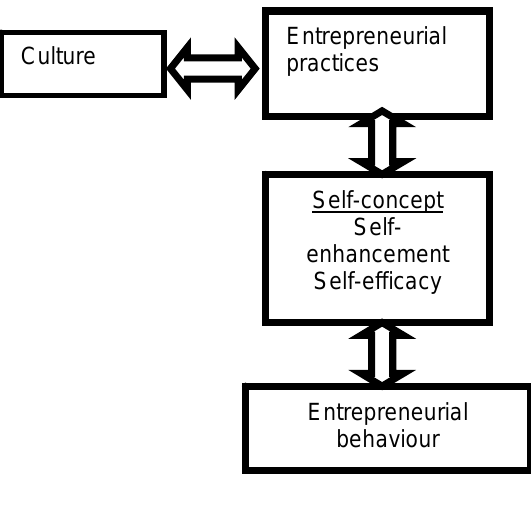
Figure 2: The cultural self-representation